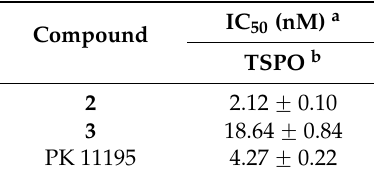
Table 2. Affinities of compounds 2 and 3 for TSPO from rat cerebral cortex.